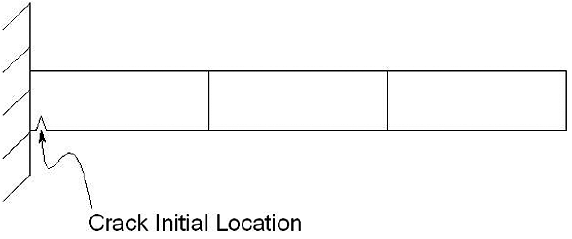
Fig. 5. Indication of crack